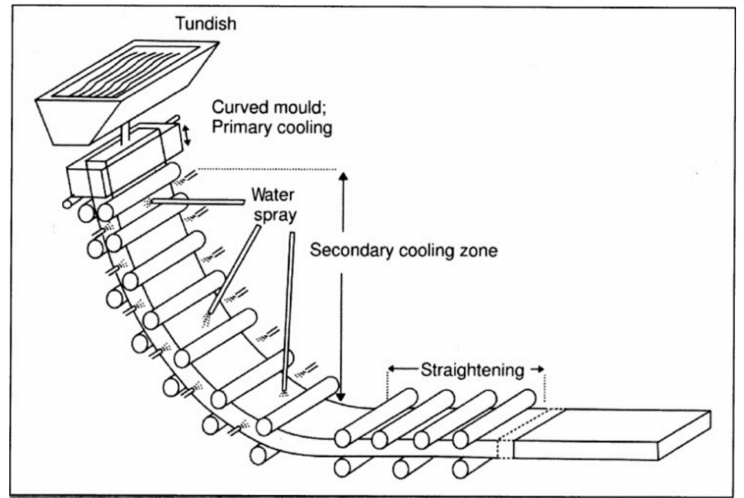
Figure 3. Schematic representation of a continuous casting